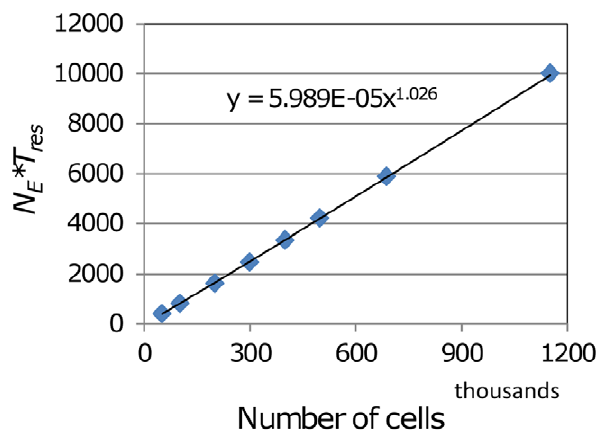
Figure 3. Fit of a power function to the product of N E and T res . Simulations were conducted with T cell population N ranging from 51 k to 1150 k and influx rates corresponding to a residence time of 12 h, to determine in each case the number of exit portals N E required for maintenance of steady state. The product (number of exit portals)x(re- sidence time) was plotted against N , and the best-fit power function determined. Further simulations confirmed that the number of exits predicted by this function also achieve steady-state system behaviour for cases with a residence time of 24 h.